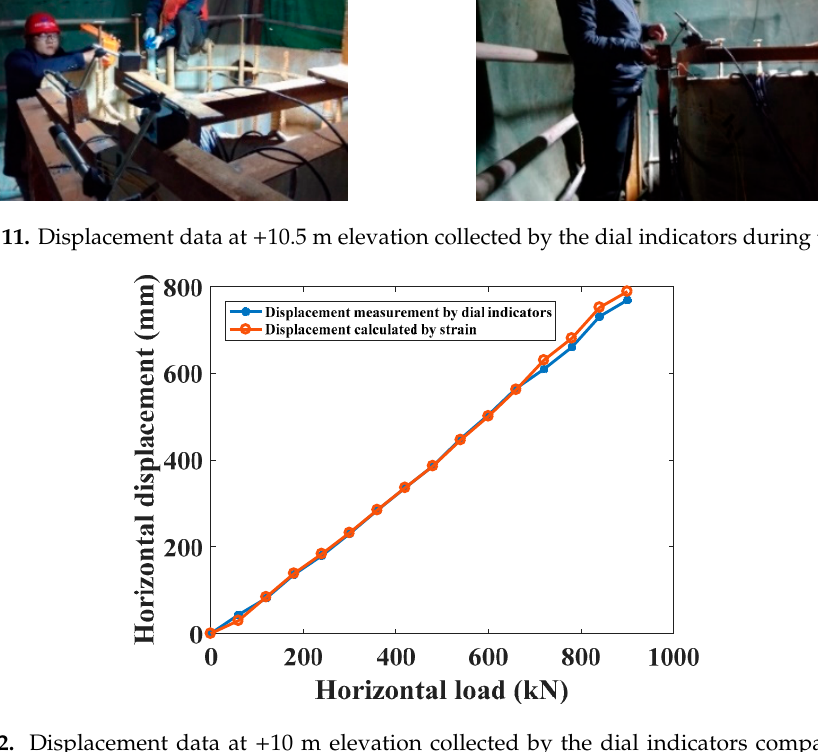
Figure 11. Displacement data at +10.5 m elevation collected by the dial indicators during the test.